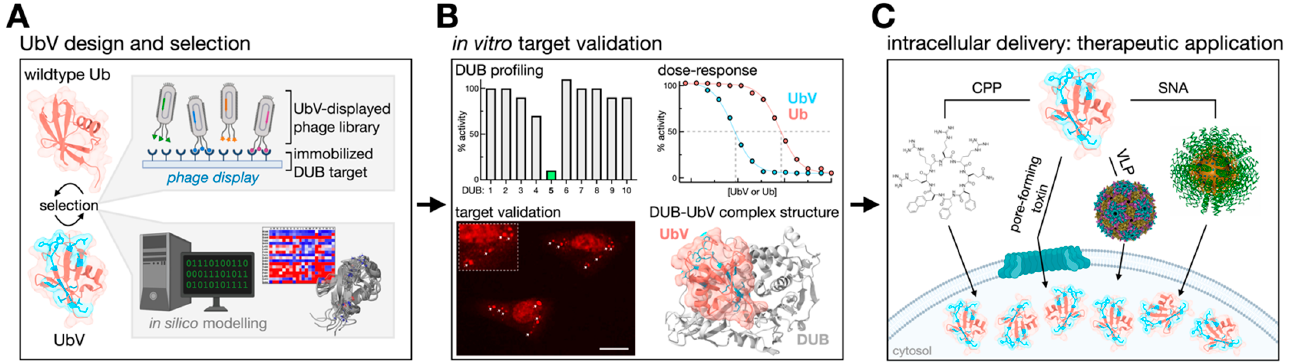
Figure 2. The pipeline of UbV development. ( A ) Wildtype Ub is randomly mutated to generate a library of UbVs that are subject to iterative rounds of screening to identify target binders, usually by phage display and/or computational methods. ( B ) The selectivity and affinity of promising leads are validated in vitro using orthogonal methods, such as profiling against a panel of homo- or heterologous targets, quantifying inhibitory concentrations by an enzyme assay, determining intracellular targets by immunofluorescence or MS, and solving the structure of UbV-bound targets. ( C ) UbVs of probe-quality potency can be examined in vivo for their therapeutic potential. A variety of cell delivery methods can facilitate the transport of purified UbVs to the intracellular space. CPP, cell-penetrating peptide; SNA, spherical nucleic acid; VLP, virus-like